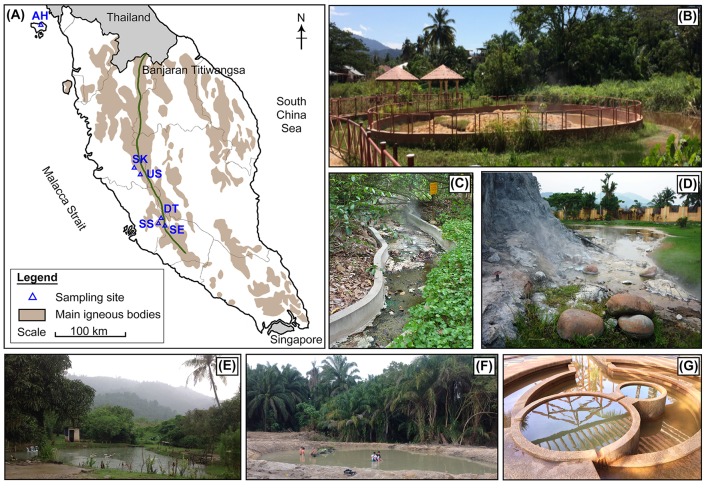
(A) Map of the locations of six selected hot springs in Malaysia: Ayer Hangat (AH), Ulu Slim (US), Sungai Klah (SK), Dusun Tua (DT), Sungai Serai (SS), and Semenyih (SE). Photographs of Malaysian hot springs sampling sites; (B) US, (C) SK, (D) DT, (E) SS, (F) SE, and (G) AH.